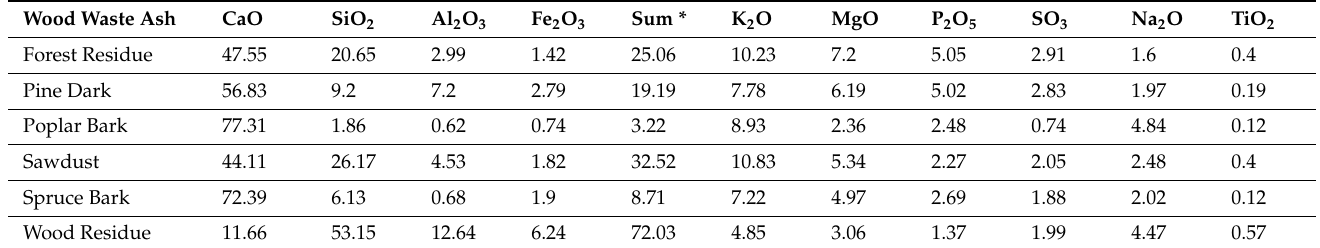
Table 13. Chemical composition of various wood ash from various timber sources (Note: Sum * is the sum of pozzolanic oxides)